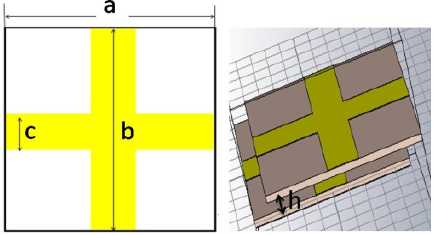
Figure 1: Unit cell of the absorber structure in